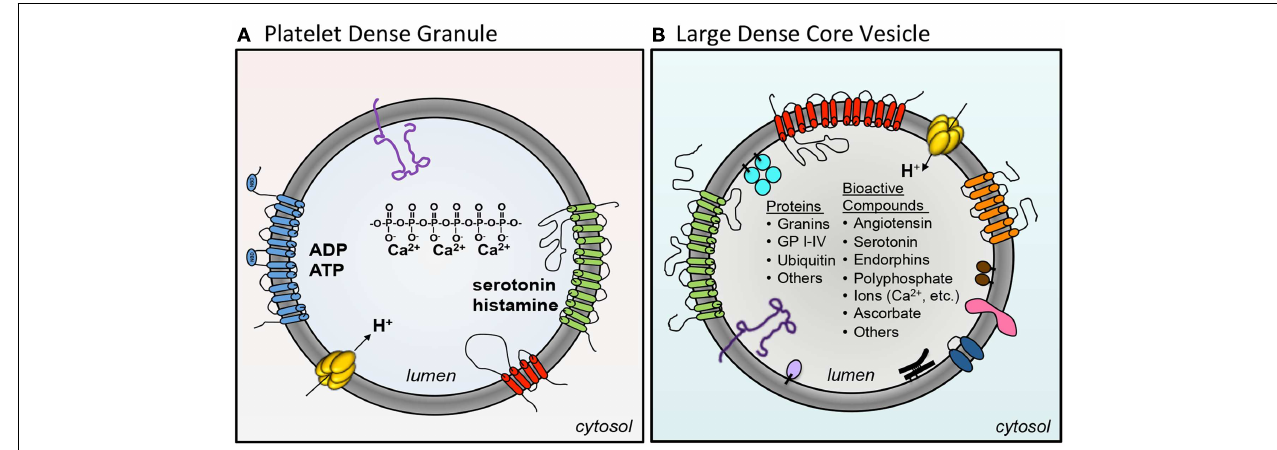
variety of membrane proteins includingVMAT1 amine transporter ( red ), H + -ATPase ( yellow ), Cytochrome b561 ( orange ), p65 ( pink ), peptidyl α -amidation monooxygenase (PAM) ( blue ), LAMP-1 ( dark purple ), and VNUT/Slc17a nucleotide carrier ( green ). In addition, the following peripheral proteins are associated with the LDCV membrane: endopeptidases PC1/PC2 ( brown ), GPIII/SGP2/clusterin ( black ), carboxypeptidase H ( lavender ), and Dopamine β -hydroxylase (D β H) ( turquoise ).The LDCV core contains a large number of different proteins and bioactive